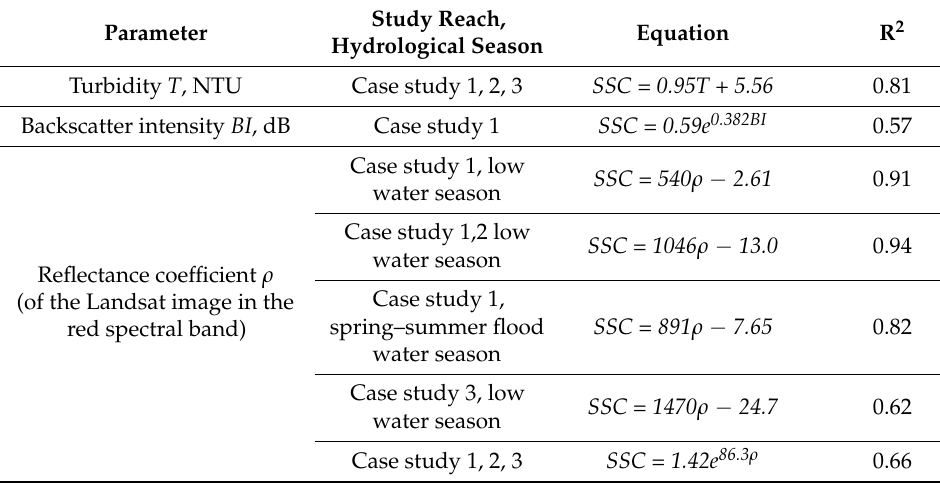
Table 2. Lena River empirical SSC